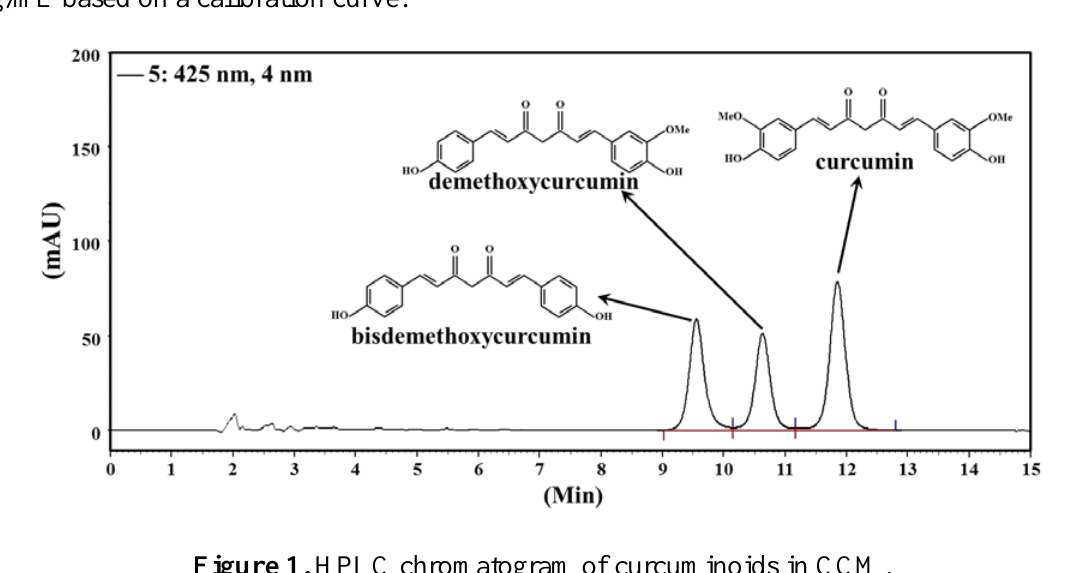
Figure 1. HPLC chromatogram of curcuminoids in